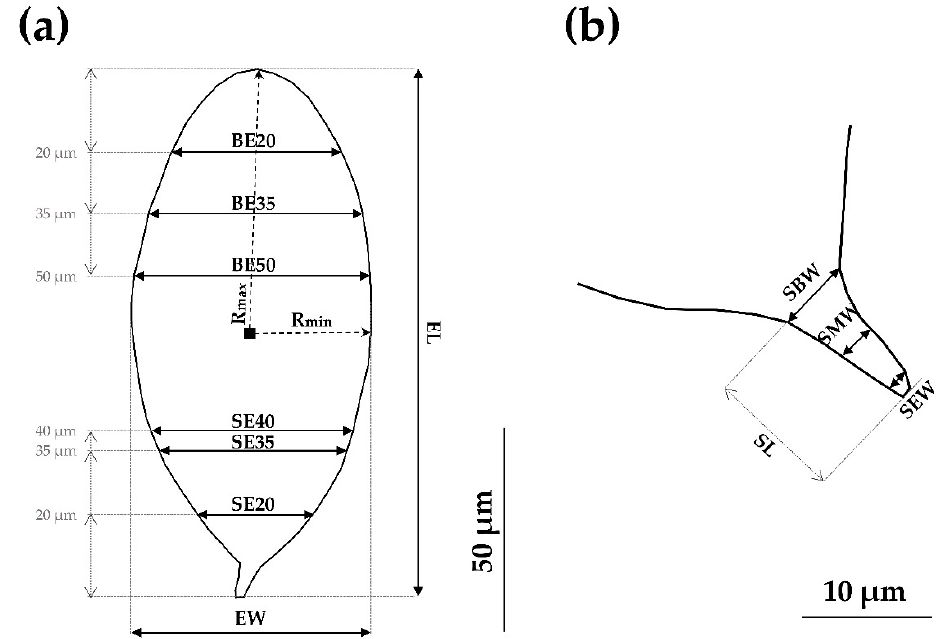
Figure 3. ( a ) Standardized measurements designed for the morphometric phenotyping of S. haemat- obium eggs. ( b ) Detail of standardized spine measurements